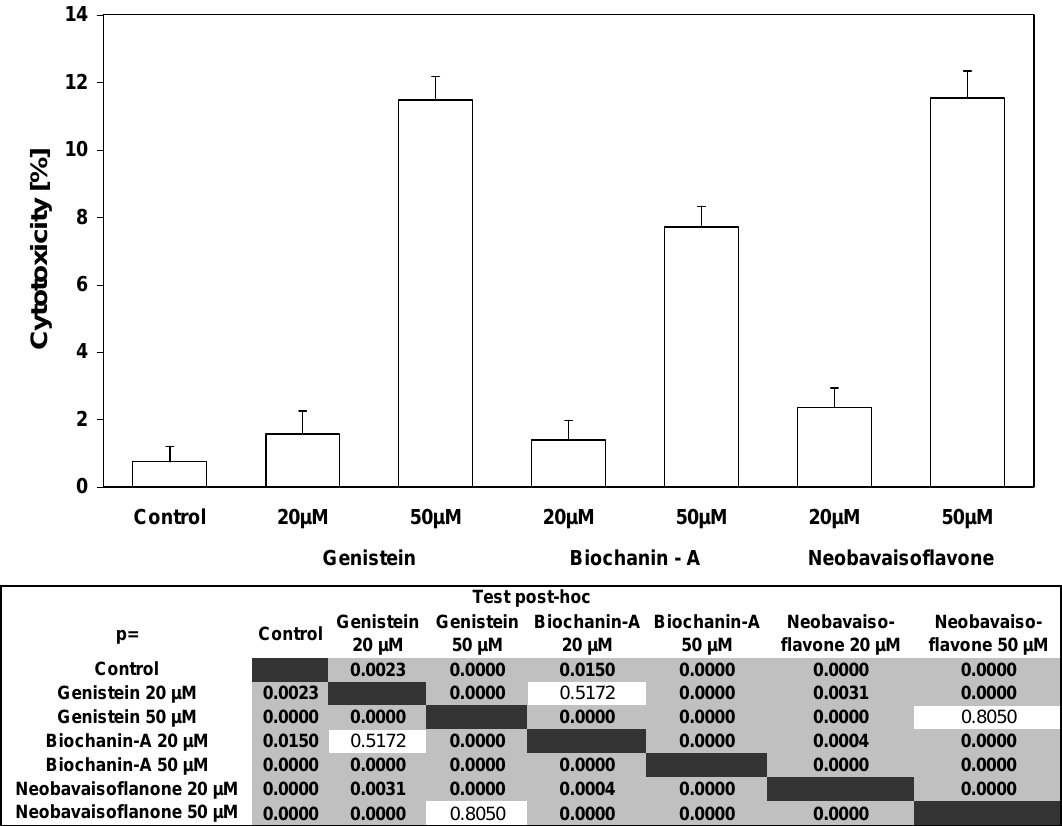
Figure 2. Cytotoxic activity of isoflavones in HeLa cancer cells. The cancer cells were incubated for 48 hours with three isoflavones: genistein, biochanin-A, neobavaisoflavone at the concentrations of 20 μ M and 50 μ M. The values represent mean ±SD of three independent experiments performed in quadruplicate (n = 12) (p < 0.05). The percentage of cell death was measured by MTT cytotoxicity